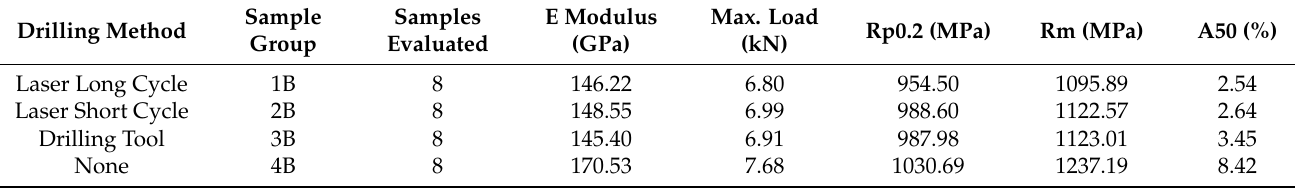
Table 10. Average values of mechanical properties—Inconel 718; material thickness 1.0 mm; tests at elevated